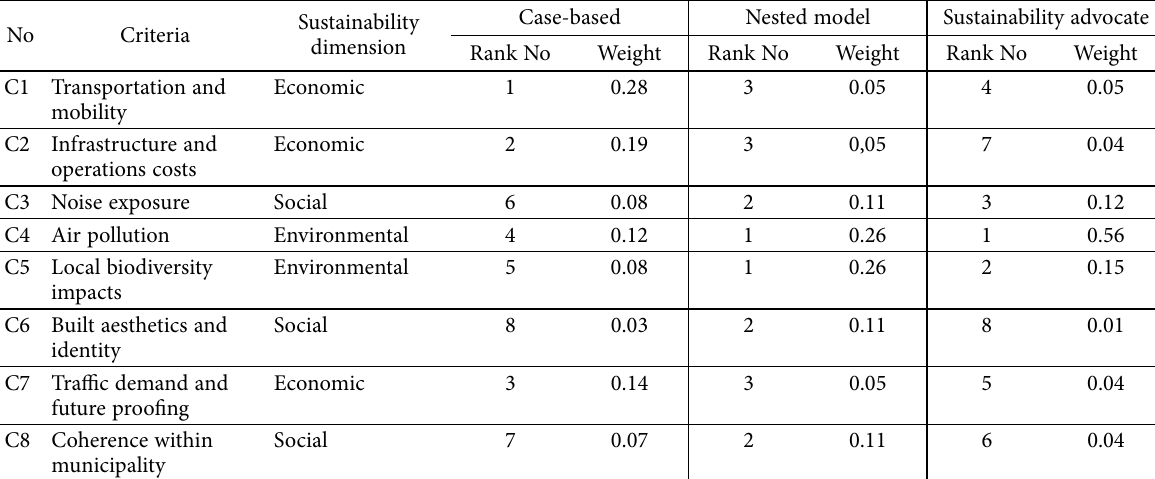
Table 3. Categorisation, ranking and weighting of the criteria